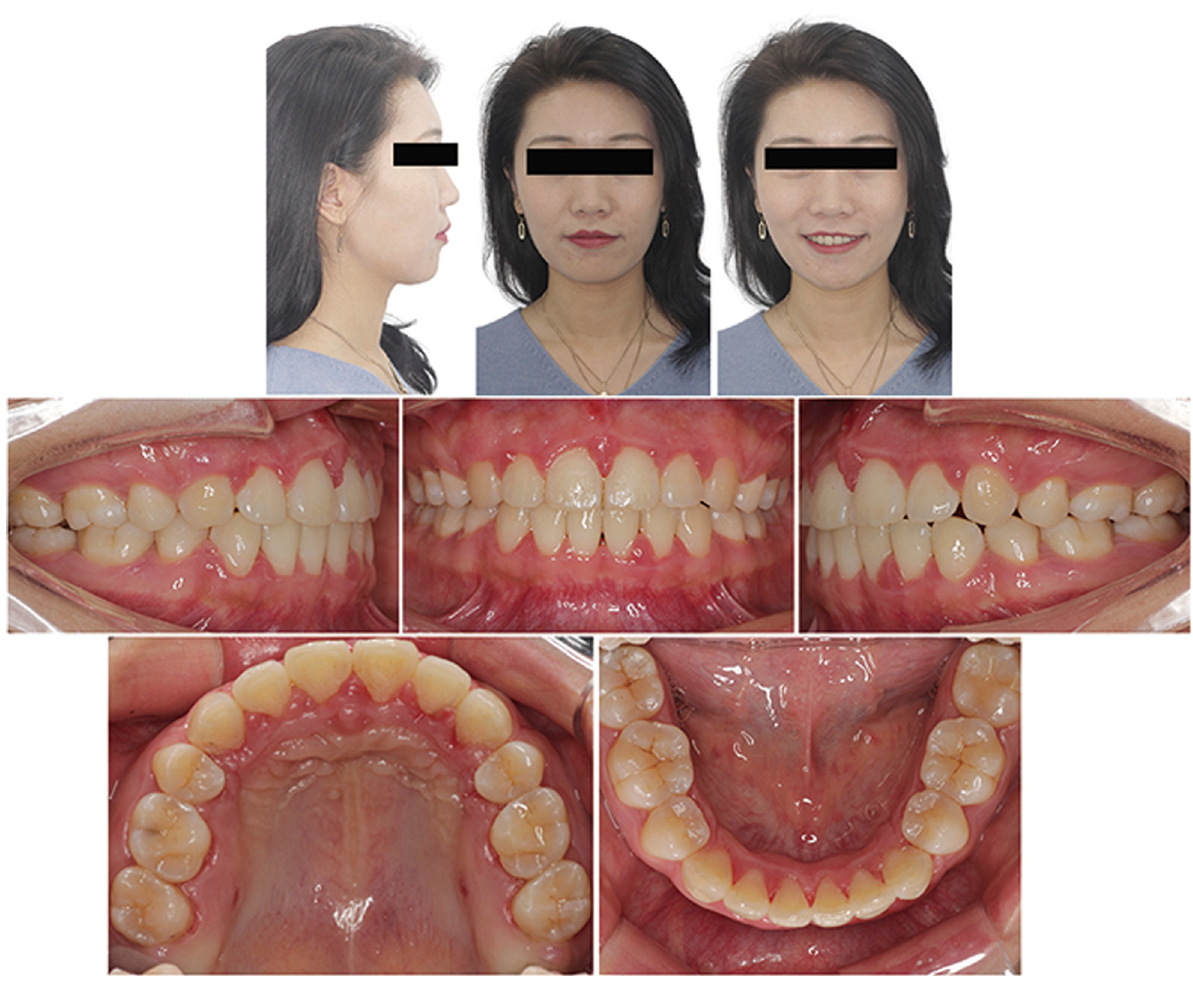
Figure 8. Posttreatment facial and intraoral